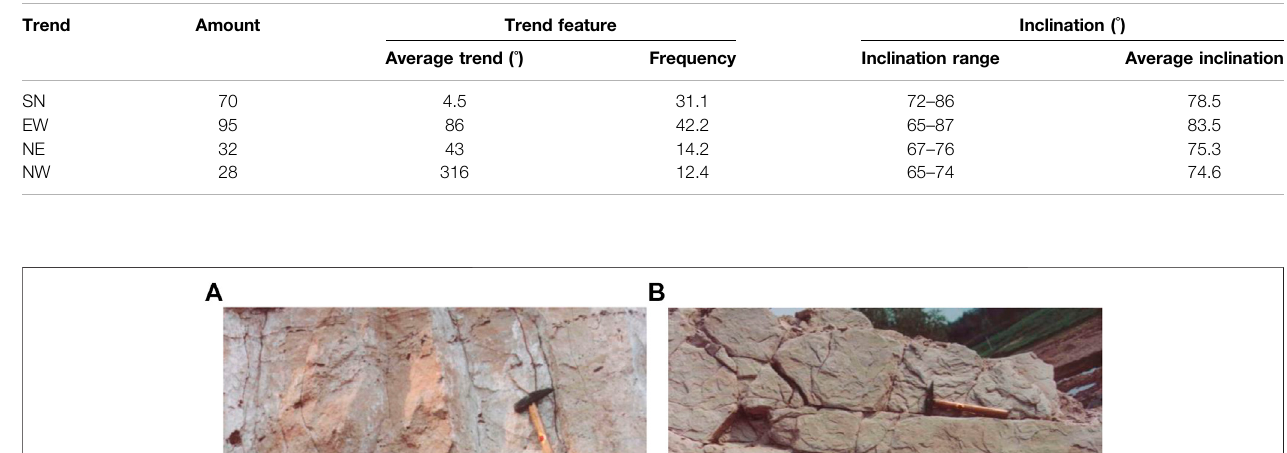
TABLE 1 | Strike distribution characteristics of similar outcrop fractures in the target reservoir.